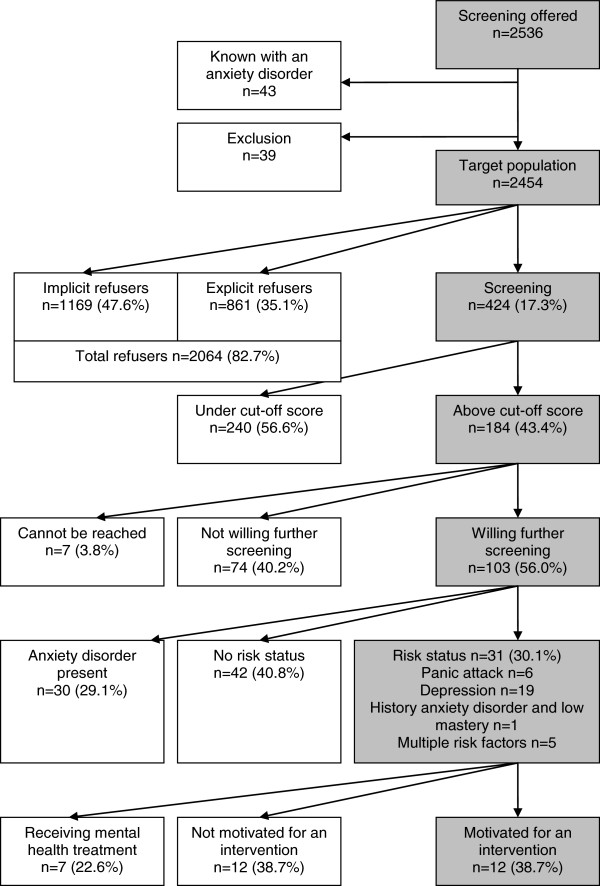
Flowchart screening.